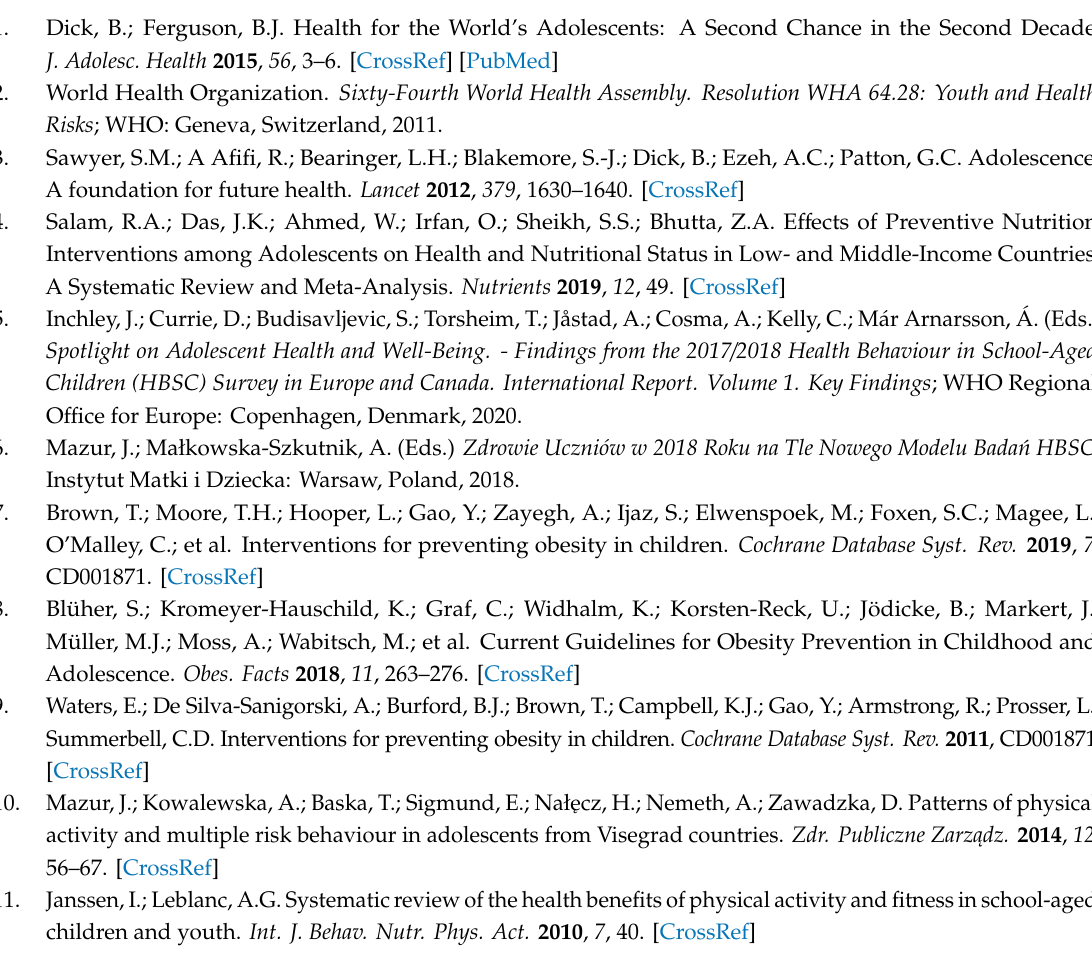
Table S1: Prevalence of health behavior by the type of intervention and body weight status (%). Table S2: Health Behavior Index (HBI) change in 3 study periods by the type of intervention. Table S3: Changes in the self-e ffi cacy before and after the Healthy Me program by the type of